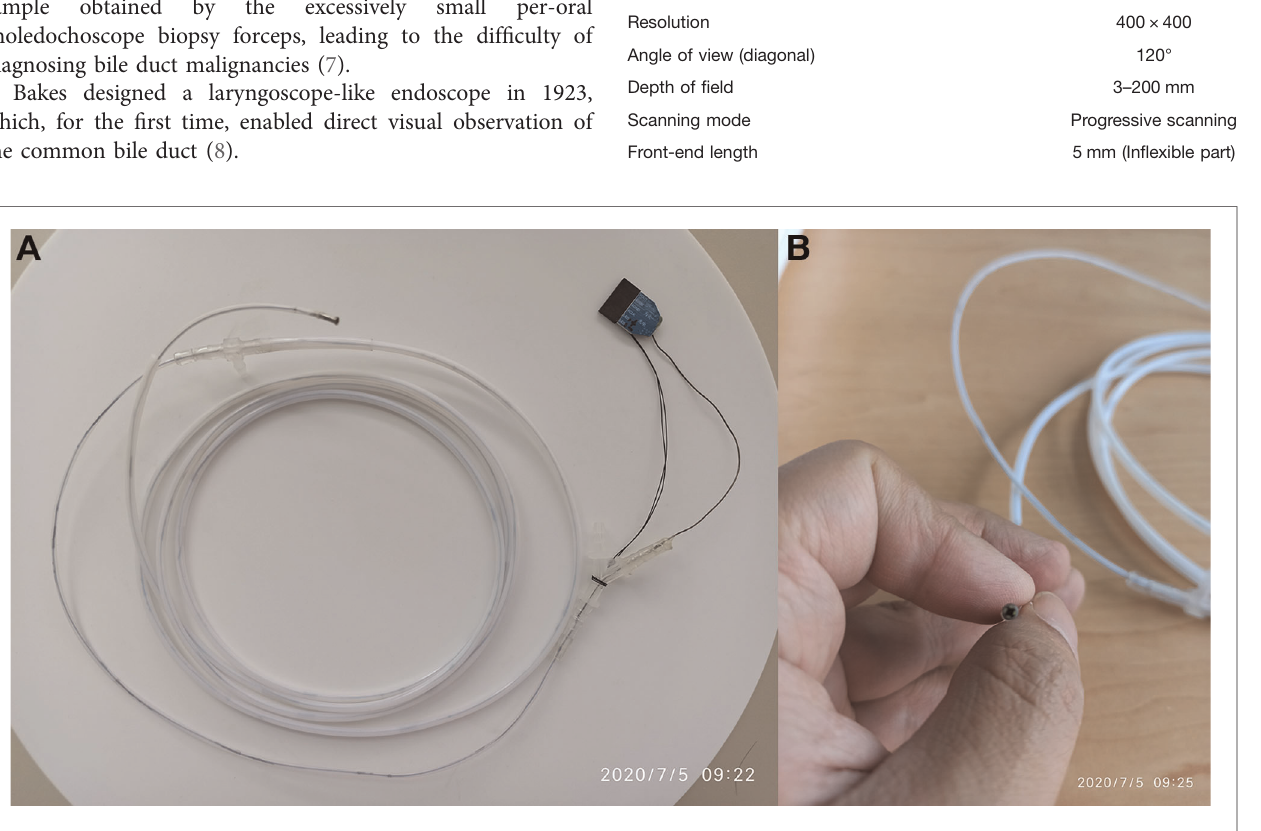
FIGURE 1 | Disposable super fi ne catheter for visual examination of bile and pancreatic ducts. ( A ) Overall Catheter, ( B ) Catheter Front